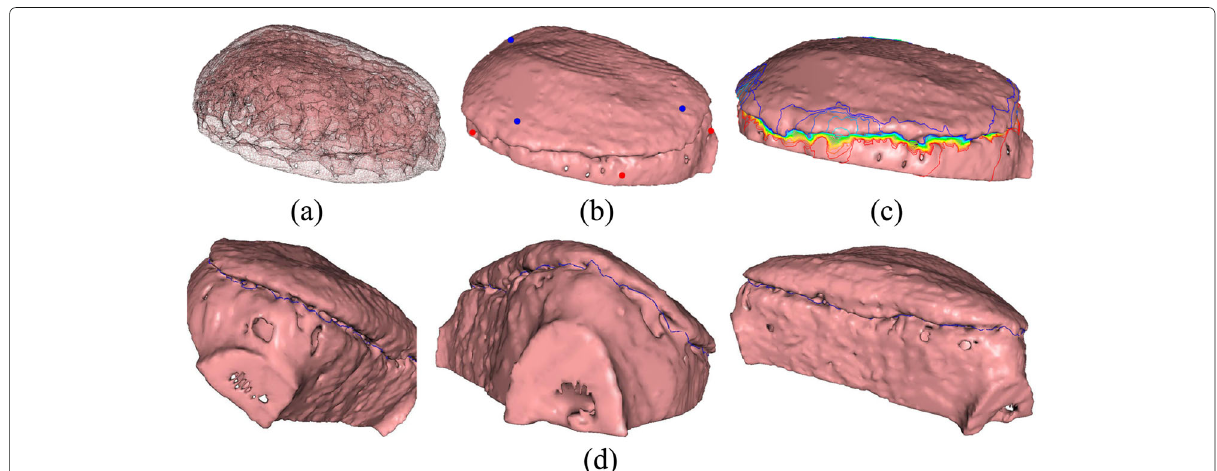
Fig. 7 Processes of the harmonic field based 3D shape priori extraction scheme. a The 3D mesh model reconstructed from the ROI. b The blue and red spheres indicate mesh vertexes of Dirichlet condition in our case equal to 1 and 0 respectively. c The isolines uniformly sampled from the generated harmonic field. d The result of the harmonic field based concave 3D gap shape priori extraction